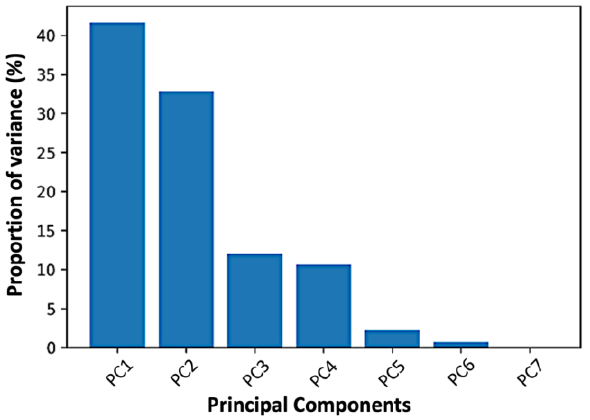
Figure A1. Scree (elbow) plot to determine the number of principal components (PC).